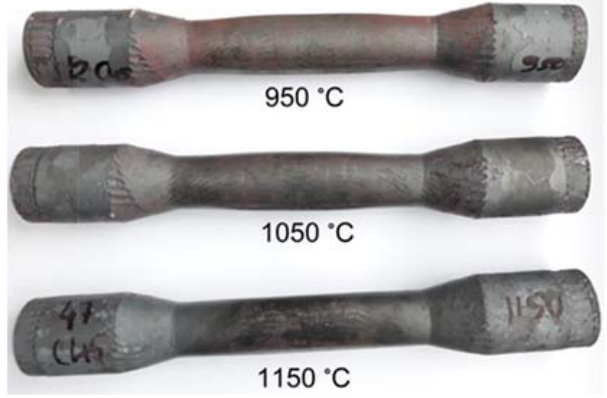
Figure 3. Forgings obtained in experimental tests. Table 1. Ovalisation sizes of the cross ‐ section of forgings.